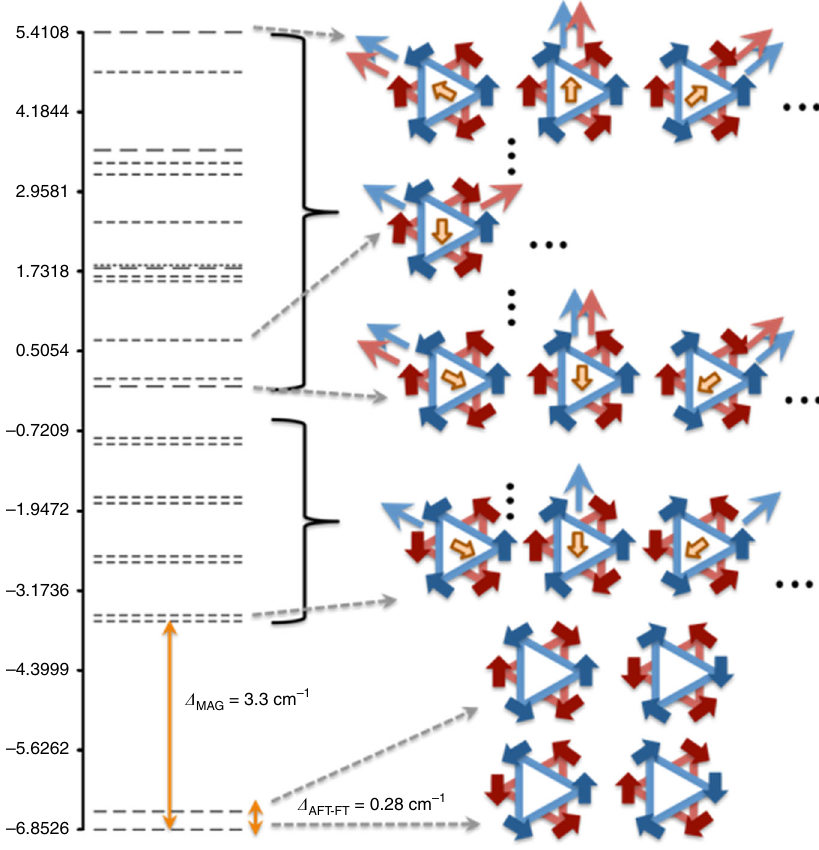
Fig. 7 Energy spectrum describes magnetic relaxation and toroidal states. The Energy spectrum of {Dy 6 Cr} calculated using the energy expressions Eqs. (3) – (7). Energies are in cm − 1 . The number of dashes for each degenerate energy level indicates the number of degenerate states associated to that level. Besides a few energy levels, it provides a graphical representation of one of the corresponding non-collinear Ising quantum states m ; M Cr j i , where the red (blue) thick arrows at the Dy III sites indicate a +15/2 or − 15/2 quantum number along the tangent direction in the lower (upper) triangular ring, a yellow thick arrow at the center indicates the spin projection of the Cr III ion relative to that of the Dy III ions, and a resulting magnetic moment in the upper (lower) ring is indicated with thin blue (red) arrow. Gap between the ground FT state ± τ 1 ; ± τ 2 ; M Cr j i , and the fi rst (AFT) ± τ 1 ; (cid:5) τ 2 ; M Cr j i excited state are Intra-ring (Eq. (5)) and inter-ring (Eq. (6)) dipolar coupling energies for the state m ; M Cr j